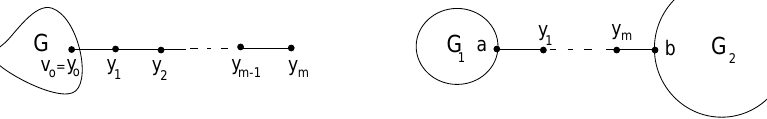
Figure 1. The Graphs G ( m ) and G 1 ( m ) G 2